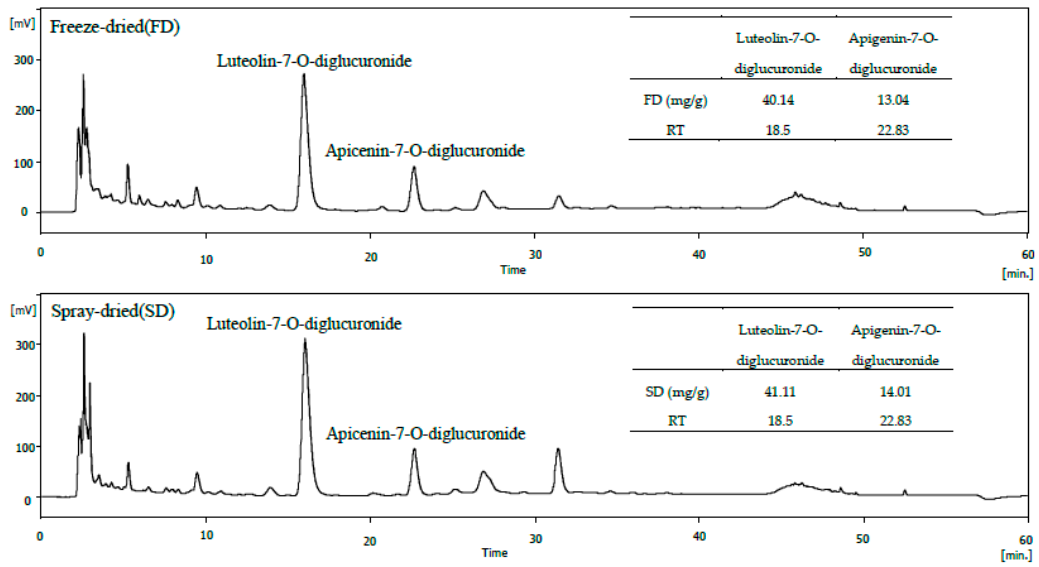
Figure 2. High-performance liquid chromatography of freeze-dried (FD) and spray-dried (SD) sample of PFA.